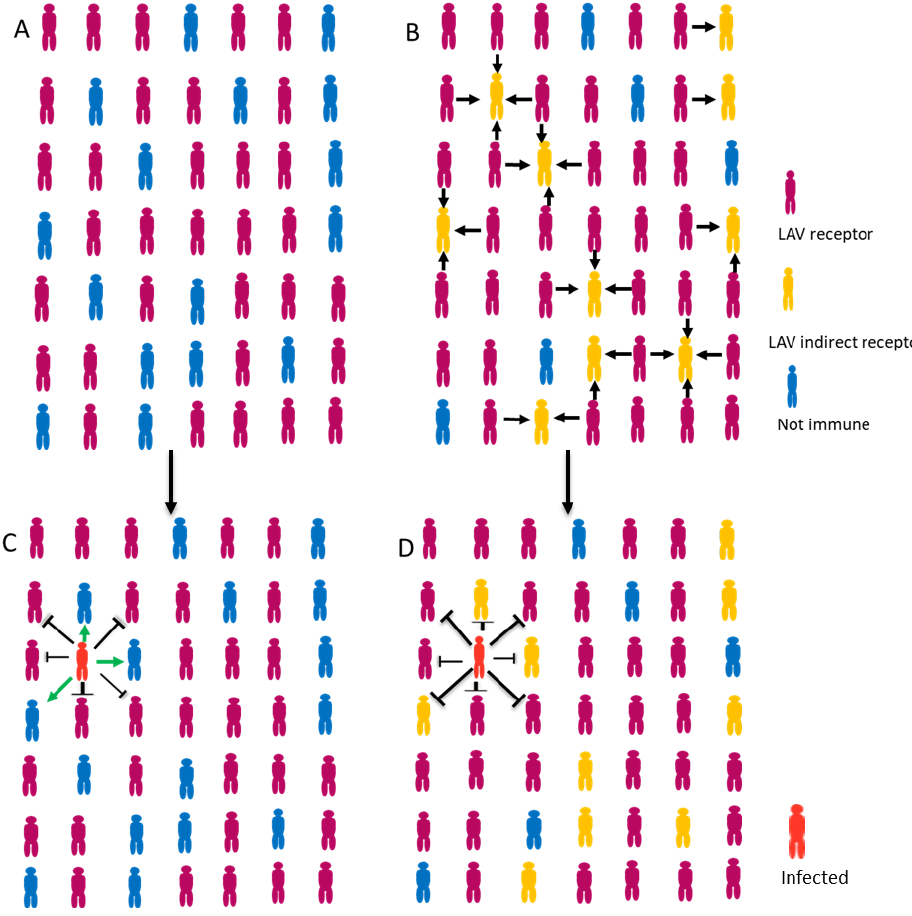
Figure 2. Schematic representation of the HI achieved with the non-proliferative vaccine application ( A ) compared with the hypothetical HI achieved with LAV application ( B ). Non-proliferative vaccines induce immunity in individuals who receive them; LAV vaccines induce immunity in individuals who receive them, as well as those contacts in whom the attenuated virus spreads, increasing the % of the immune population. The spread of the pathogenic SARS-CoV-2 in a population with 60–70% immune individuals is still possible ( C ), but it would be more difficult or would no longer occur in a population with a higher of immune individuals ( D